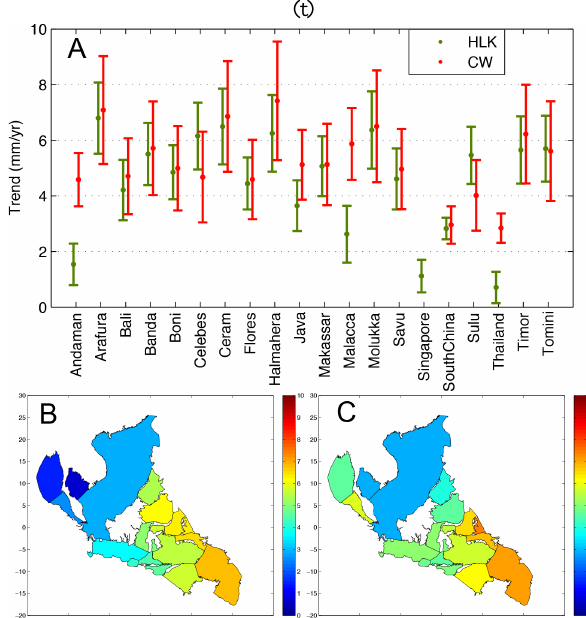
Figure 5. Southeast Asian sea average sea level trends over the 17- year time period from 1959 through 1975 shown plotted as trend values with standard error (a) and as color maps for the HLK re- construction (b) and the CW reconstruction (c)